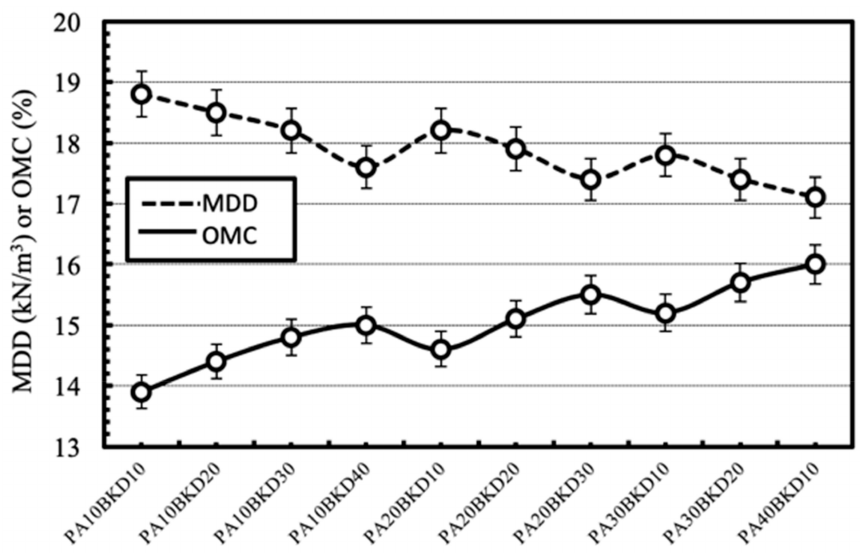
Figure 9. Variation in compaction characteristics with varying combinations of pond ash and brick kiln dust.